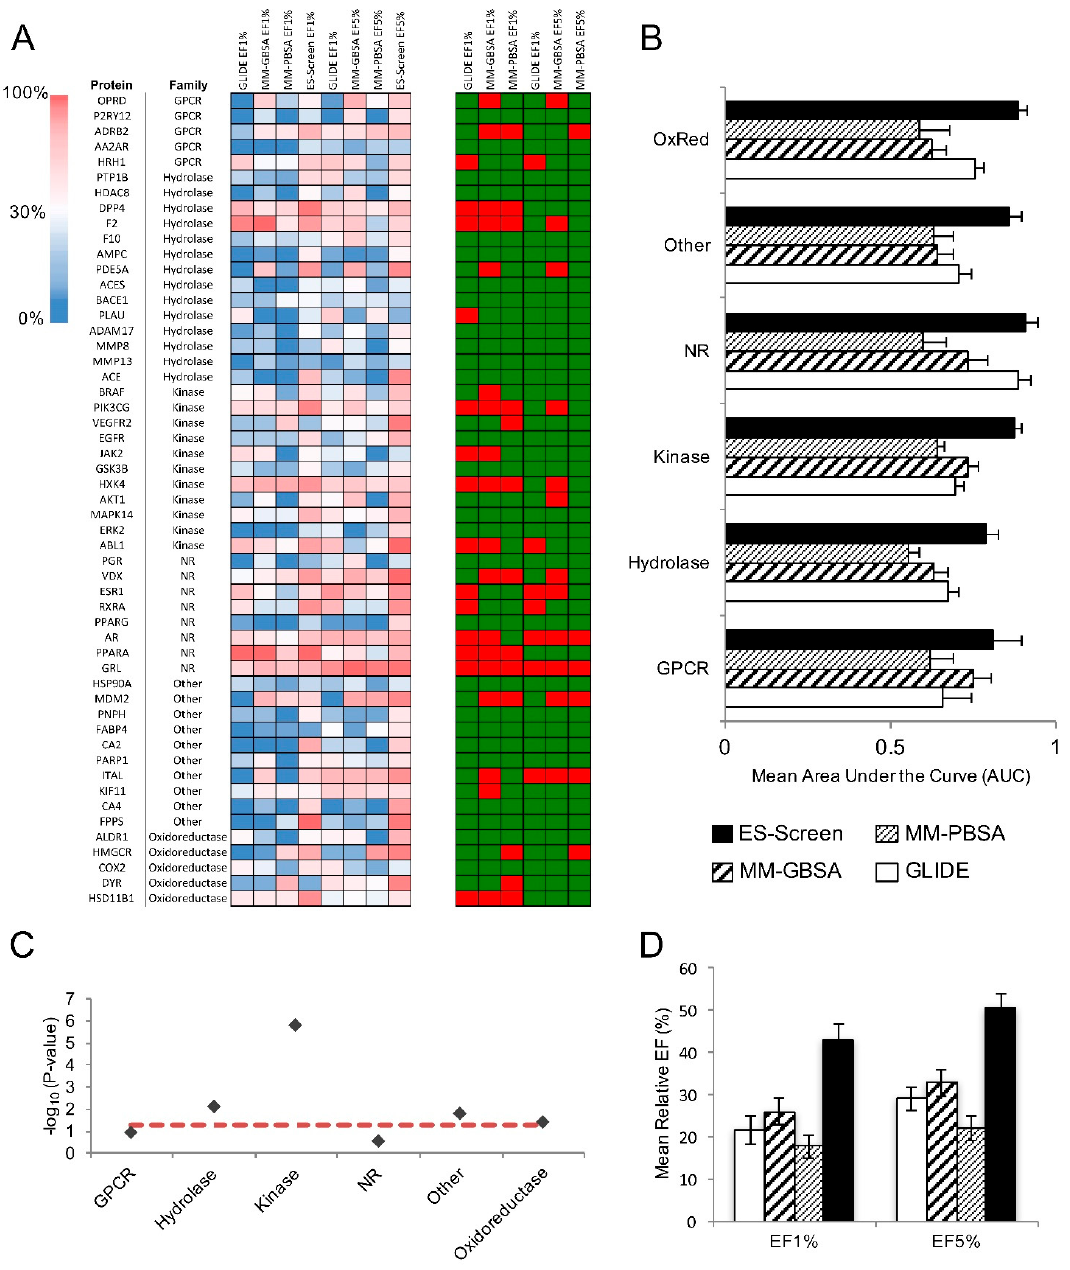
Figure 5. ES-Screen performance compared to GLIDE-SP for virtual screenings using a chemical dataset of FDA-approved and experimental drugs. ( A ) Heatmap of relative enrichment factors (EF1% and EF5%) for individual protein targets with respect to each virtual screening method; colored boxes for EF1% improvement and EF5% improvement represent whether ES-Screen performs superiorly (green box) or inferiorly (red box) with respect to each method; ( B ) Performance measured using the mean area under the curve (AUC), obtained from ROC curves, within each protein family, error bars represent standard errors of the mean (abbreviations: GPCR, G protein-coupled receptor; NR, nuclear receptor; OxRed, oxidoreductase; p -value < 0.05 on one-tailed t -test with respect to ES-Screen). ( C ) Log-transformed p -values of one-tailed t-tests comparing the ES-Screen to GLIDE docking, red dashed line represents statistical significance level at p < 0.05. ( D ) Mean relative enrichment factors for the top 1% and 5% of the database screened across all protein targets (N = 53) are depicted; significance at p < 0.01 and p < 0.05 reported using a paired, one-tailed student’s t -test with respect to ES-Screen (black